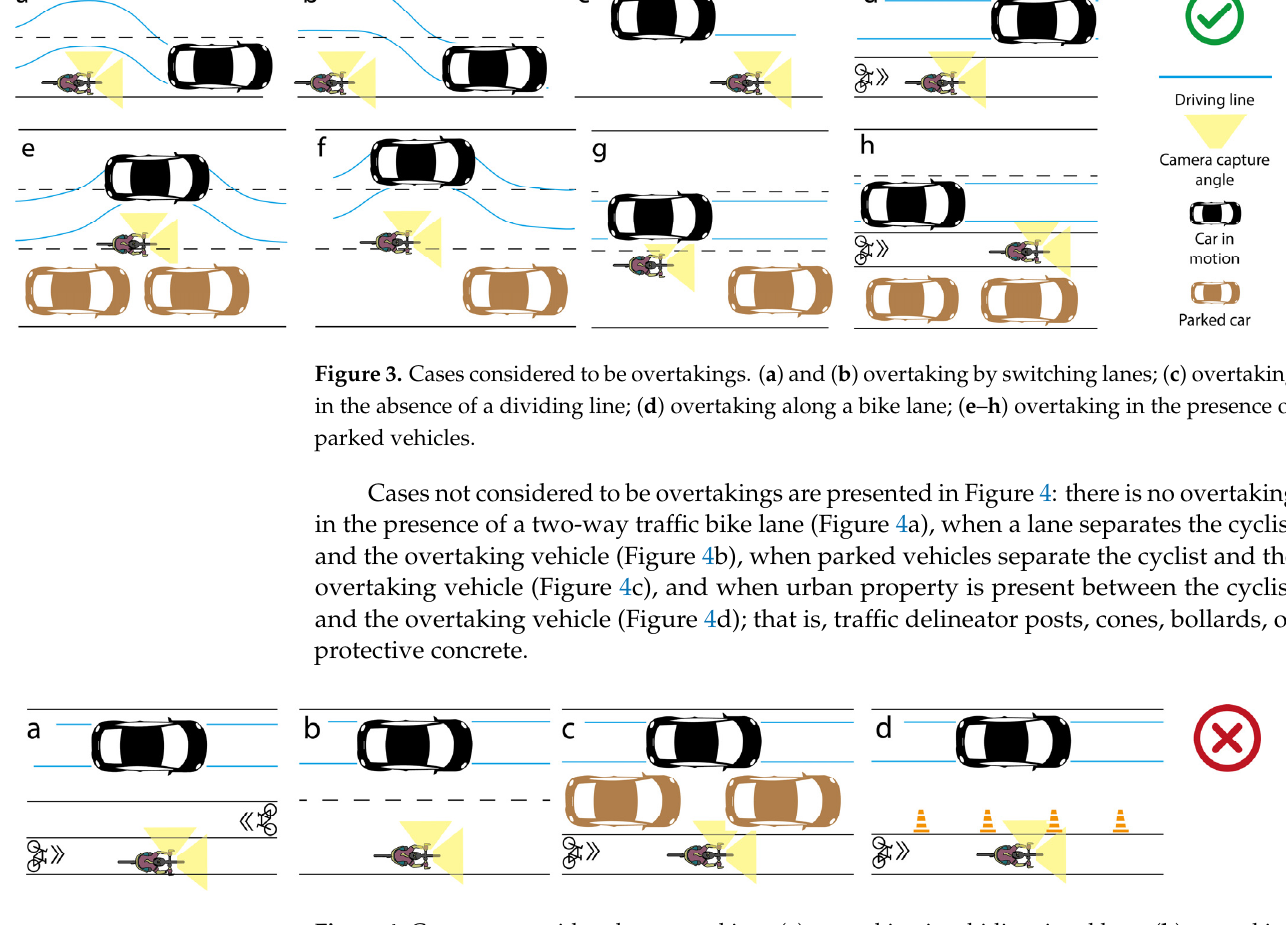
Figure 4. Cases not considered as overtakings ( a ) overtaking in a bidirectional lane; ( b ) overtaking with a lane separating the cyclist from the vehicle; ( c ) overtaking alongside parked cars; ( d ) overtaking alongside a protected bicycle lane.